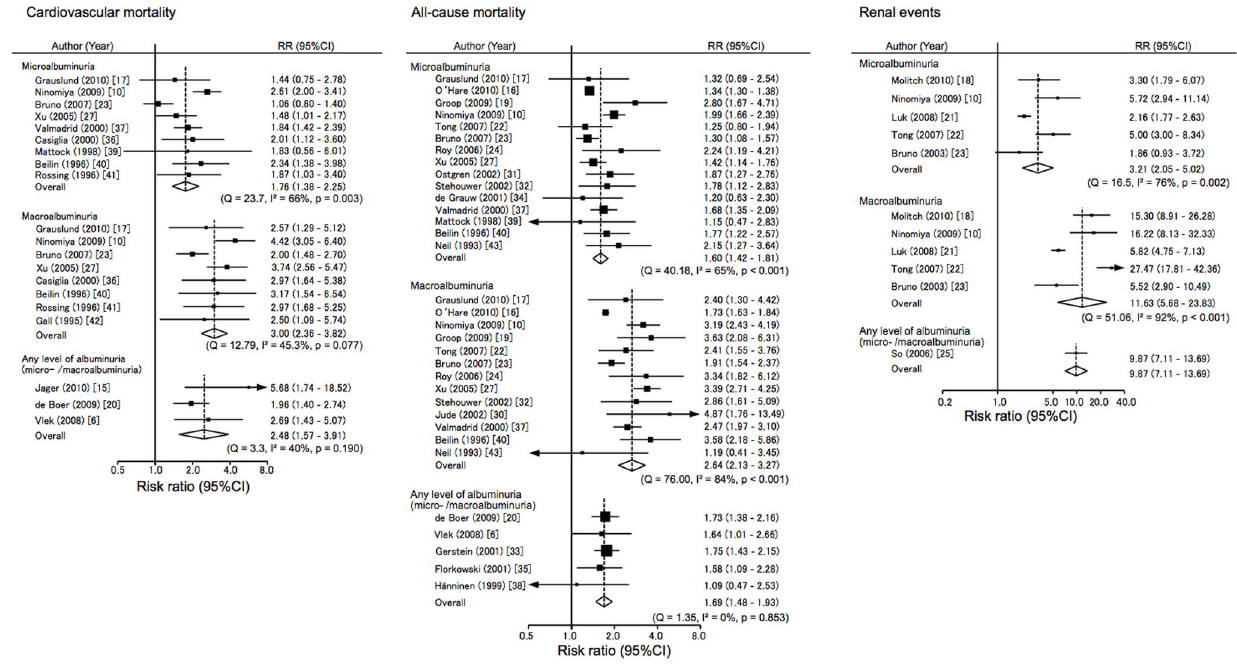
Figure 2. Risk ratio for the association between albuminuria and cardiovascular mortality, all-cause mortality, and renal events compared with normoalbuminuria. Abbreviations: CI, confidence interval; RR, risk ratio.